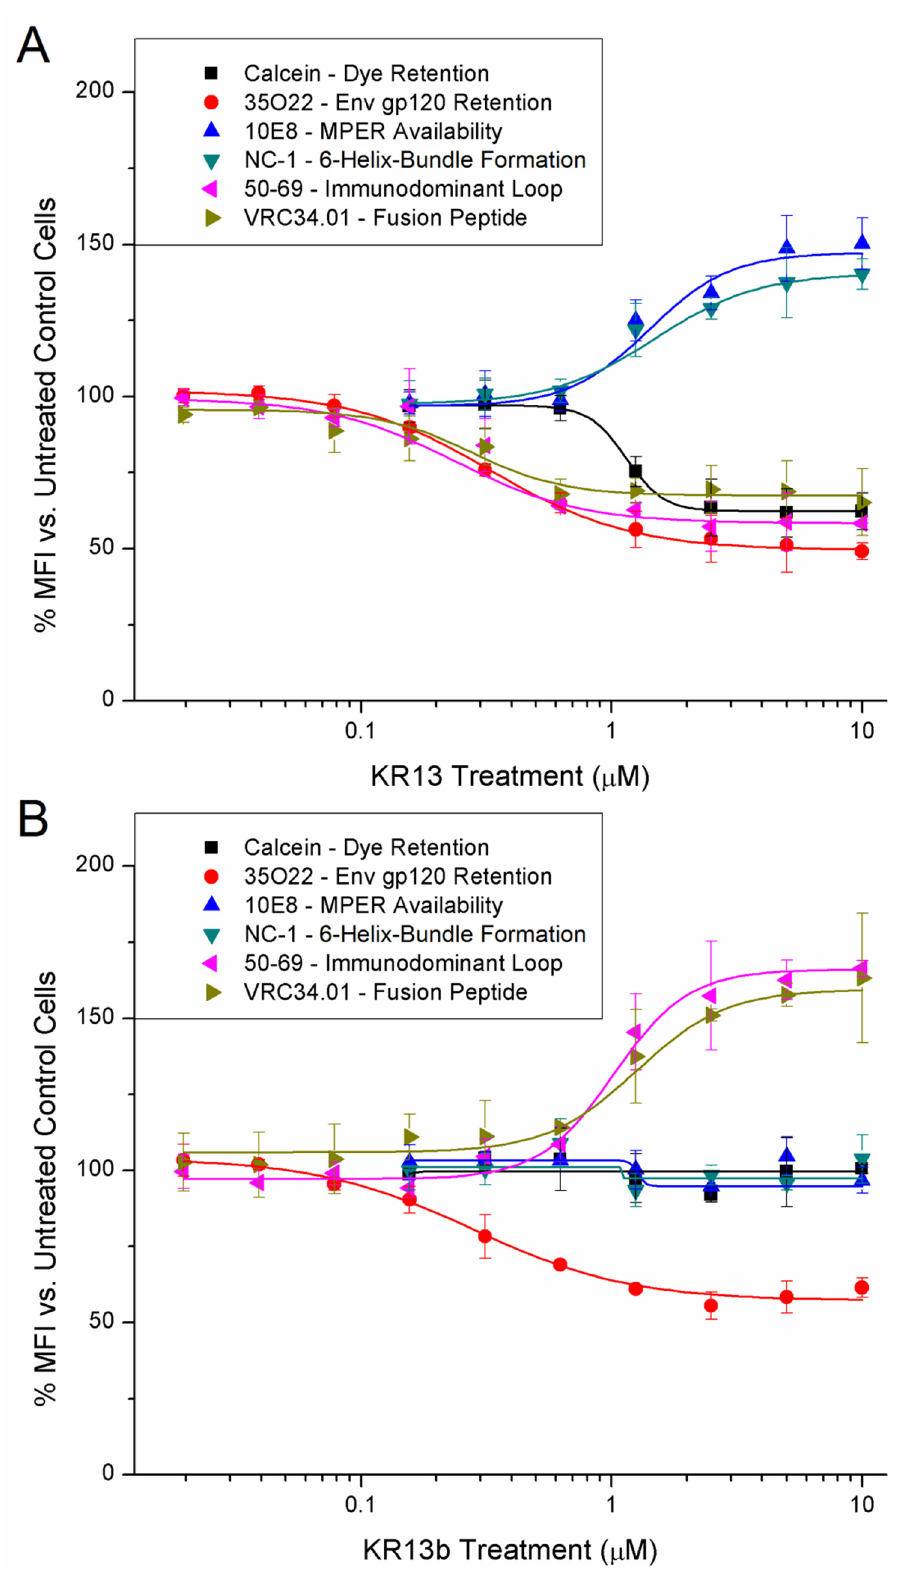
Figure 3. Treatment with KR13 ( A ) and KR13b ( B ) result in dose-dependent changes in epitope exposure and membrane disruption (for KR13). Cells were treated with compounds for 4 h at 37 °C before wash, retrieval, and fixation. Data shown are the average of four independent experiments, and error bars represent the standard deviation of the mean. At least 5000 cells were examined for each condition of an independent experiment.